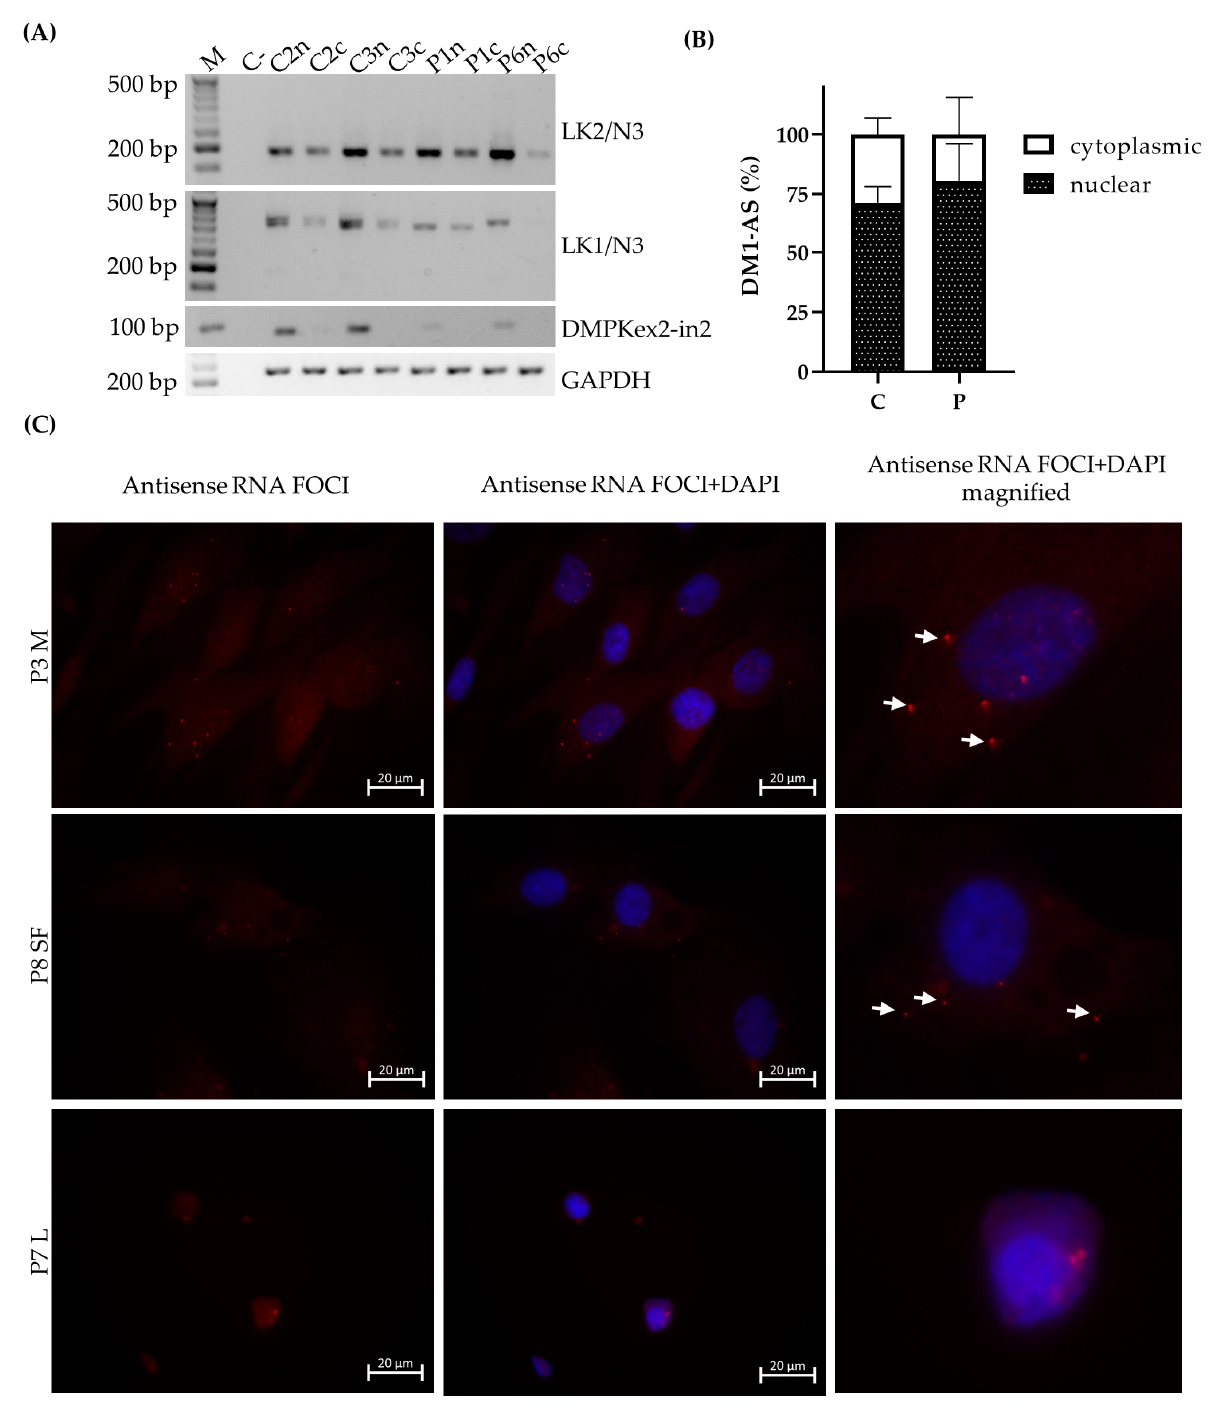
Figure 2. DM1-AS presence in the cytoplasm. ( A ) DM1-AS specific RT-PCR for subcellular fractionated skin fibroblasts with two primer combinations, LK2/anti-N3 and LK1/anti-N3. ( B ) Quantification of DM1-AS signals; bars represent mean +SD. ( C ) Presence of antisense RNA foci in all three cell types of DM1 patients. Cy3-labeled (CTG) 10 probe (RED) showing antisense RNA foci; nuclei indicated by DAPI (blue) and white arrows indicate cytoplasmic antisense RNA foci. Abbreviations: C = control; P = DM1 patient; n = nuclear; c = cytoplasmic; DMPKex2-in 2 = pre-mRNA DMPK as a nuclear marker; GAPDH = endogenous control; M = myoblasts; SF = skin fibroblasts; L = lymphoblastoids.